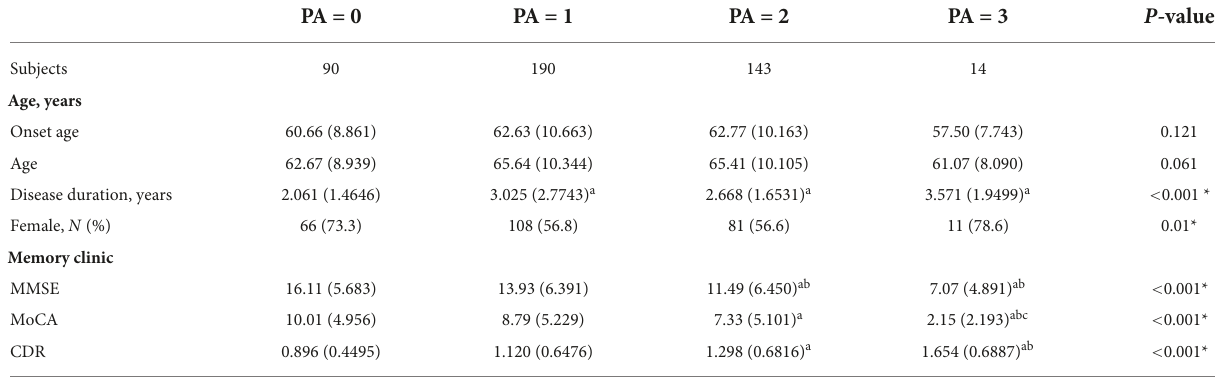
TABLE 3 Demographic features and PA scale of the samples.